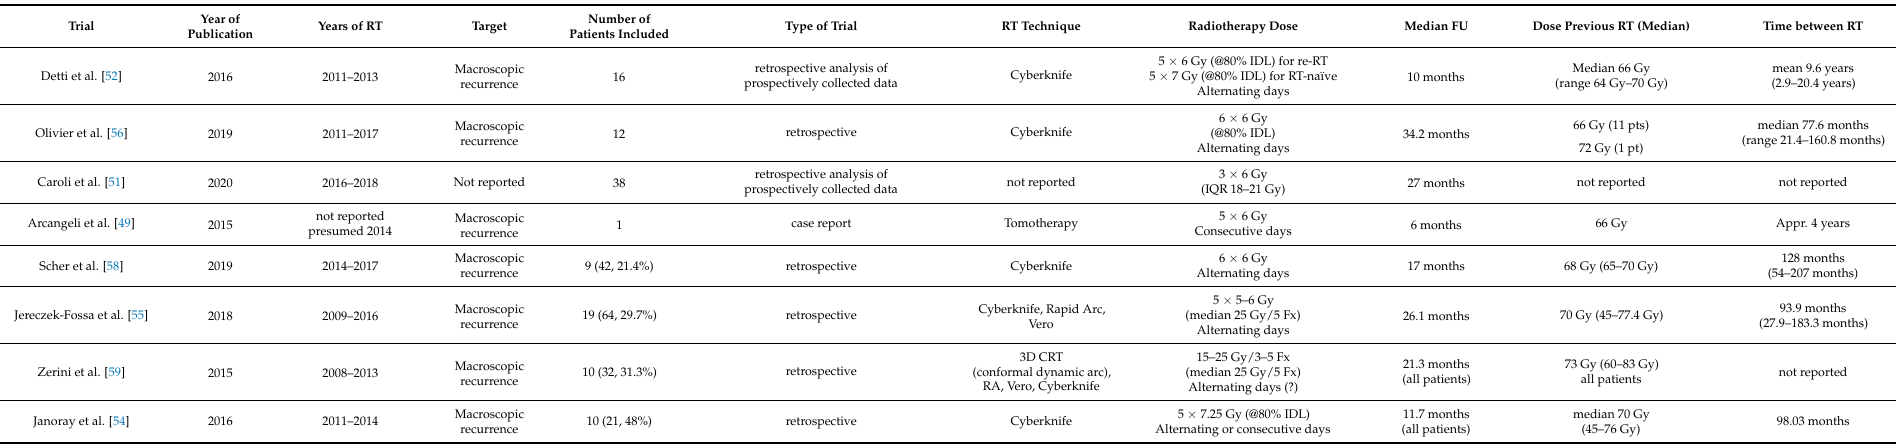
Table 2. Overview of trials including patients with salvage prostate or prostate bed SBRT with prior radiotherapy (data below for included patients with prostate bed RT) ( n =